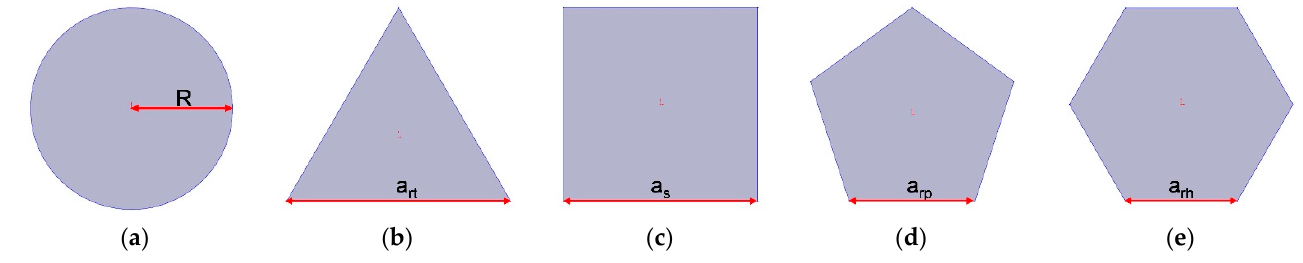
Figure 4. The cross-sectional shape of air domain in the aperture for various cross-sectional shapes. ( a ) Round; ( b ) regular triangle; ( c ) square; ( d ) regular pentagon; and ( e ) regular hexagon.